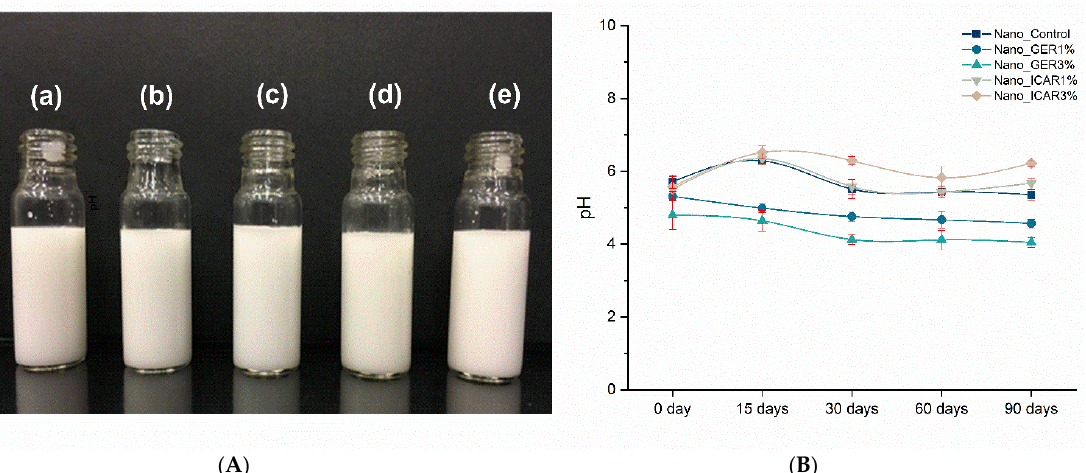
Figure 1. ( A ) Macroscopic view of the Nano_Control polymeric nanocapsule formulations: